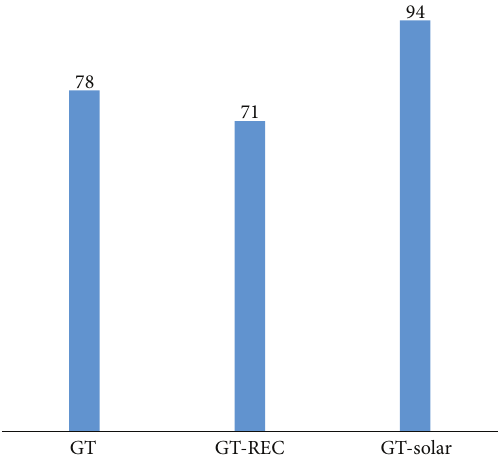
Figure 6: Contribution of exergy destruction in resource conver- sion components in different cycles.